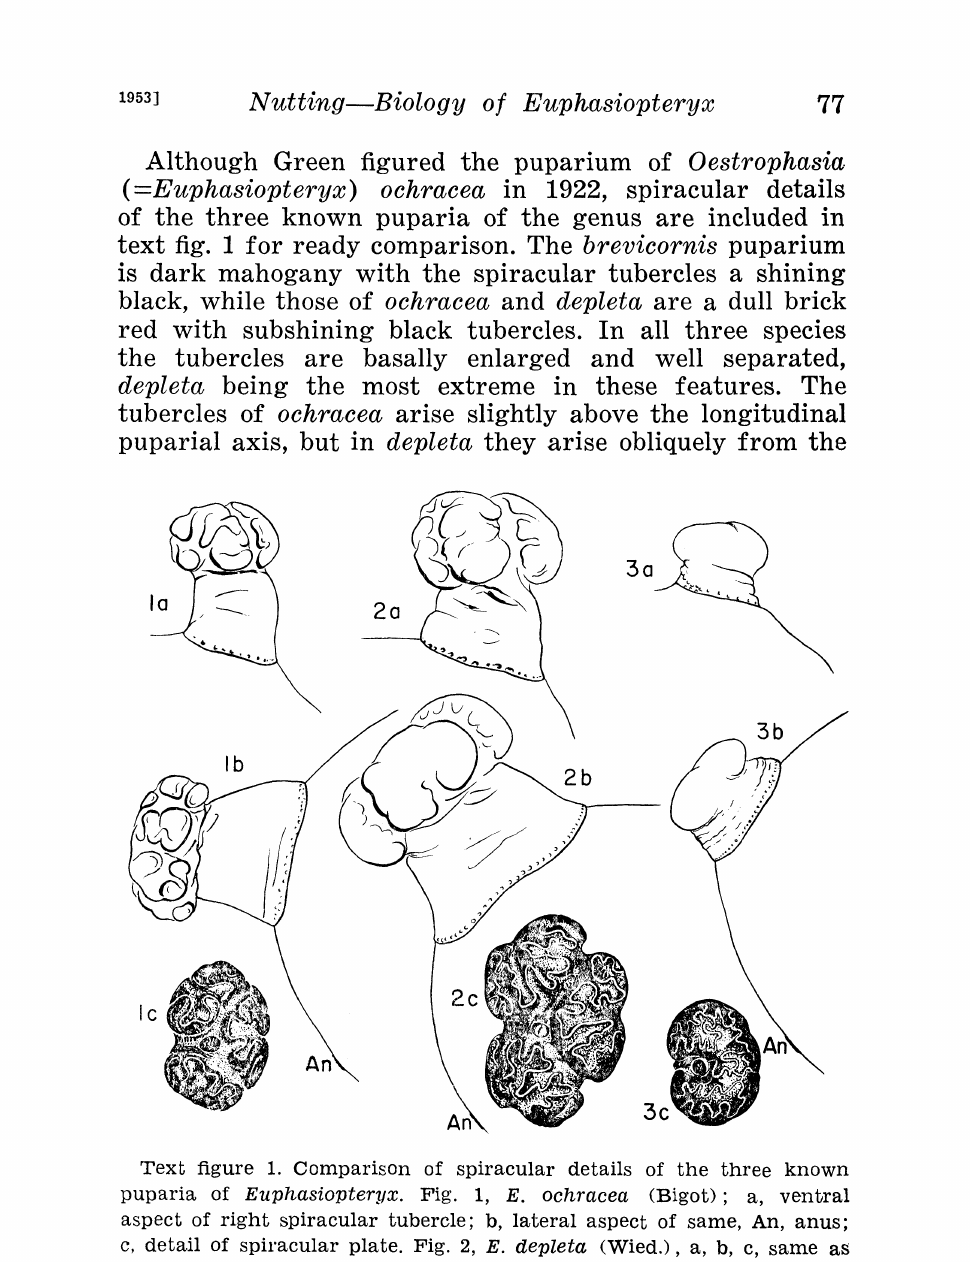
Text figure i. Comparison of spiracular details of the three known puparia of Euphasiopteryx. Fig. 1, E. ochracea (Bigot); a, ventral aspect of right spiracular tubercle; b, lateral aspect of same, An, anus; c, detail of spiracular plate. Fig. 2, E. depleta (Wied.), a, b, c, same as fig. 1. Fig. 3, E. brevicornis (Tns.), a, b, c, same as fig. 1.